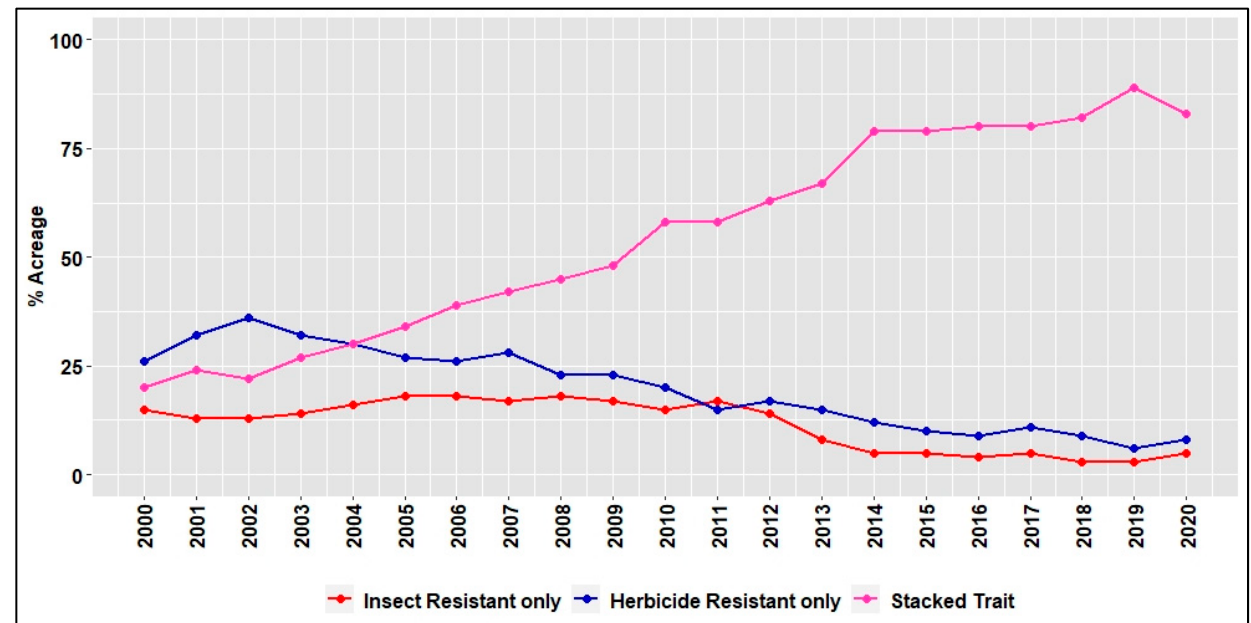
tion in total area planted with upland cotton from 2019, adoption of both traits increased